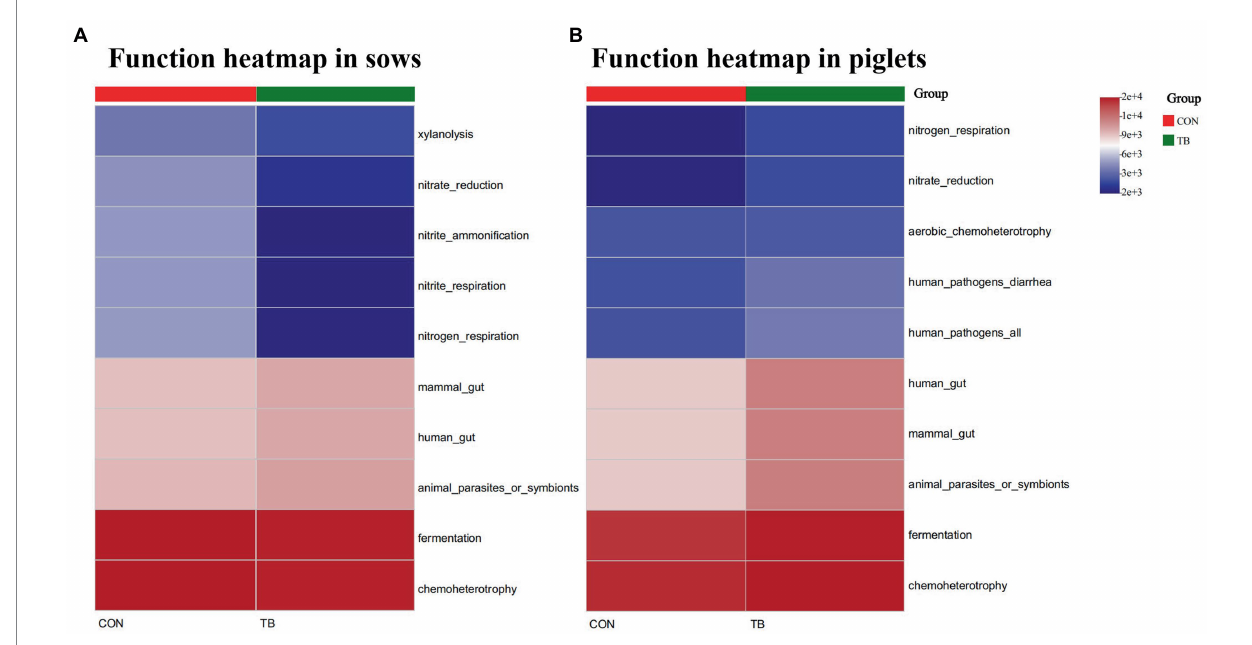
FIGURE 6 Relative abundance of the predicted function of fecal microbiota in sows (A) and piglets (B) . CON, basal diet; TB, basal diet +500 g/t tributyrin. The abscissa is the sample name, and the ordinate is the species name. The abundance change of different species in the sample is displayed by the color gradient. The color gradient is shown on the right side of the